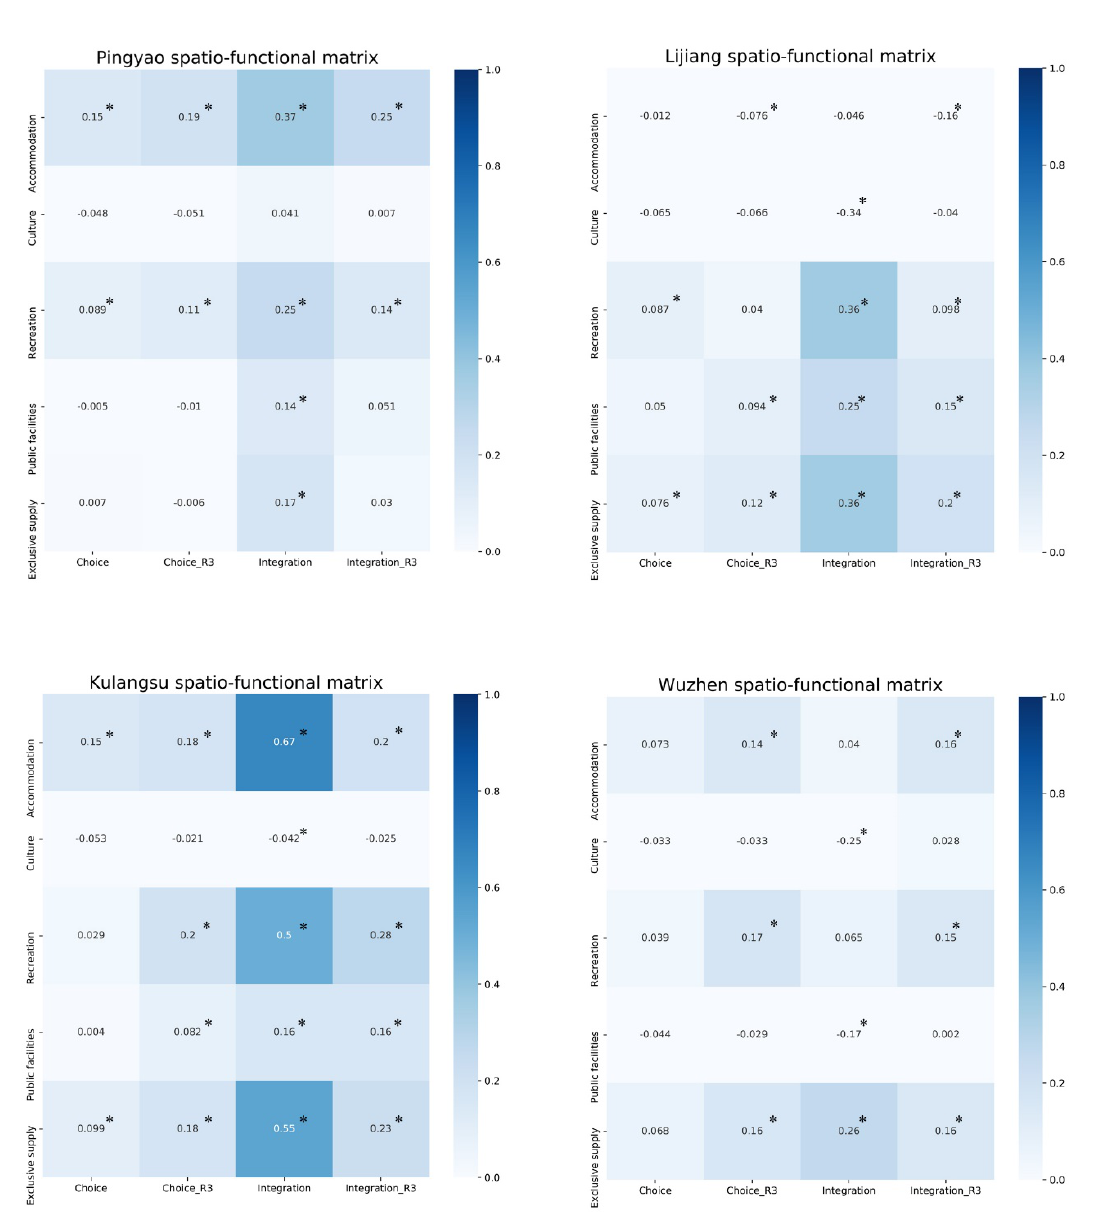
Figure 13. The correlation matrix between the five types of land use and axial line analysis measures: choice, choice_R3, integration, and integration_R3 where a darker blue colour represents a higher Pearson coefficient r value (* correlation is significant at the 0.05 level for 2-tailed).